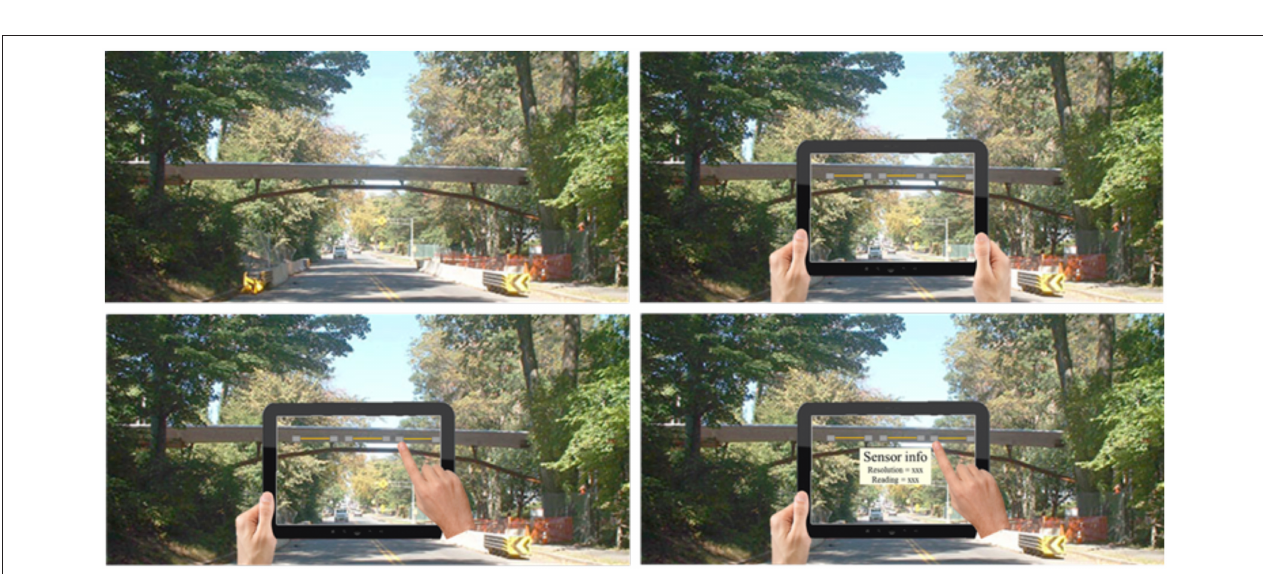
FIGURE 1 | Decision model for documenting and communicating infrastructure data and metadata.